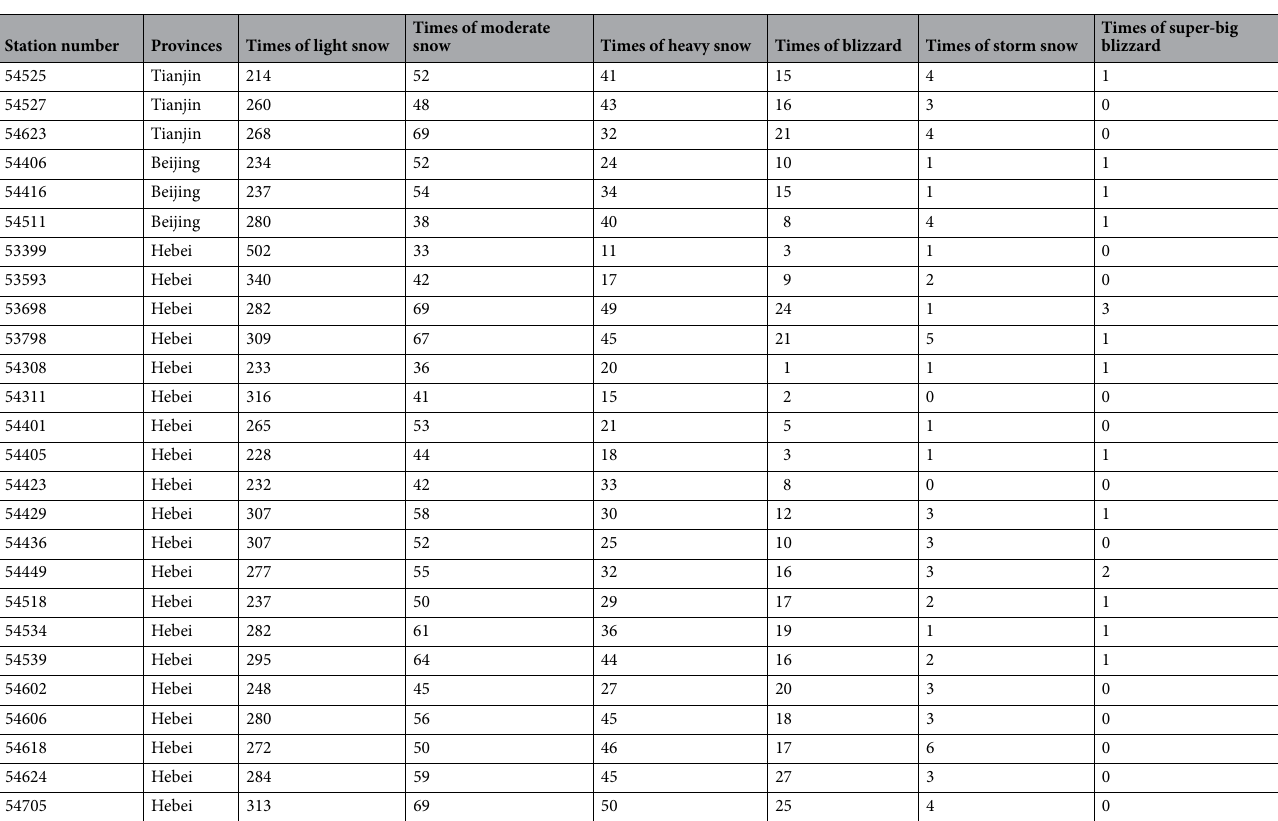
Table 6. Occurrence times of different snowfall grades in the Beijing–Tianjin–Hebei region within 1, 2, 11, and 12 months from 1968 to